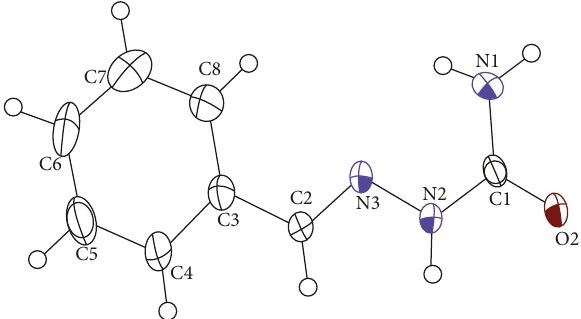
Figure 3: ORTEP diagram of BDSC − with the atomic numbering scheme.